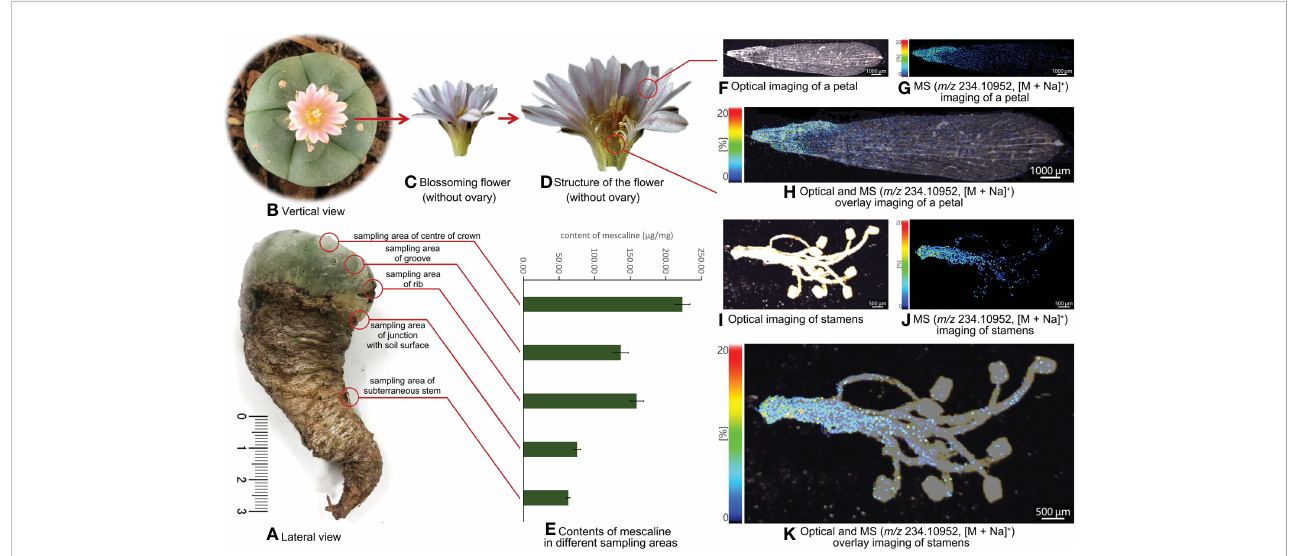
FIGURE 2 (A) Lateral view of Lophophora williamsii and the different sampling areas. (B) Vertical view of Lophophora williamsii . (C) The blossoming fl ower of Lophophora williamsii (without ovary). (D) Internal structure of the fl ower of Lophophora williamsii (without ovary). (E) Mescaline content in different sampling areas of Lophophora williamsii . (F) Optical imaging of the petal of Lophophora williamsii. (G) MS imaging of the petal with a resolution of 30 µm ( m/z 234.10952, [M + Na] + ). (H) Optical and MS overlay imaging of the petal. (I) Optical imaging of stamens of Lophophora williamsii. (J) MS imaging of stamens with a resolution of 30 µm ( m/z 234.10952, [M + Na] + ). (K) Optical and MS overlay imaging of